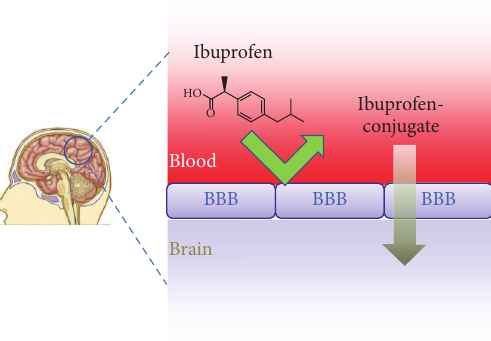
Figure 1: The presence of BBB prevents the ibuprofen internaliza- tion into the brain. Our objective is to make ibuprofen conjugate pass through the